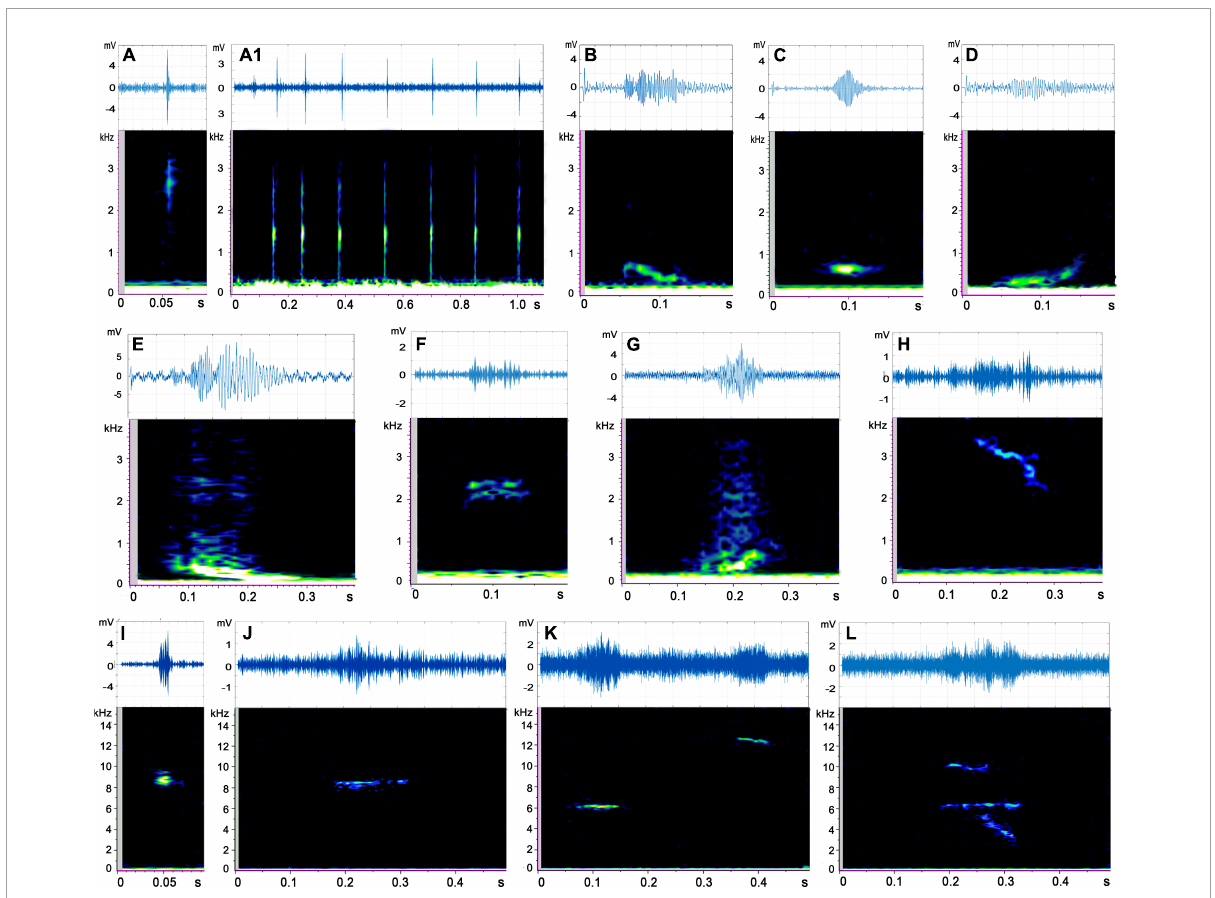
FIGURE2 Spectrogram and waveform views of call types produced by Trachemys scripta elegans . (A–L) Corresponds to the 12 call types of red-eared sliders, and A1 represents successive occurrences of A call type. All spectrograms were obtained with Raven Pro 1.5 using Hamming windows with 512 pt fast Fourier transform. The waveforms were drawn in MATLAB